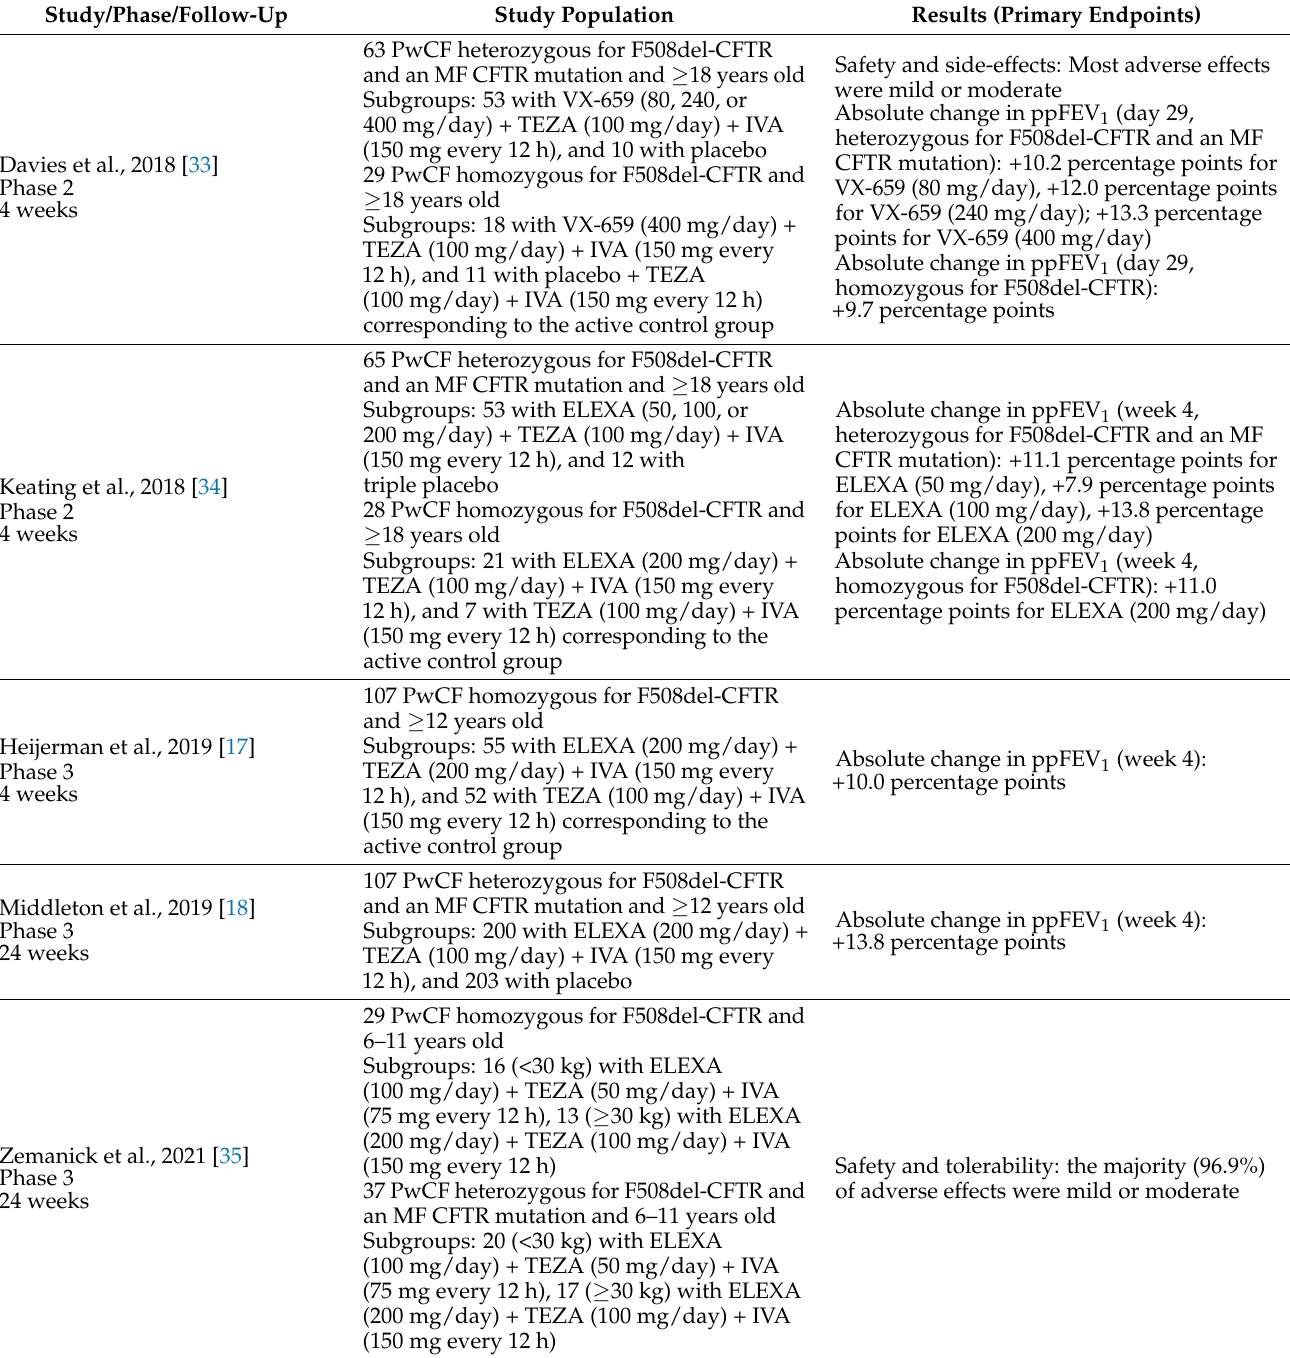
Table 2. Clinical trials assessing the safety and efficacy of VX-659 or ELEXA in combination with TEZA plus IVA in